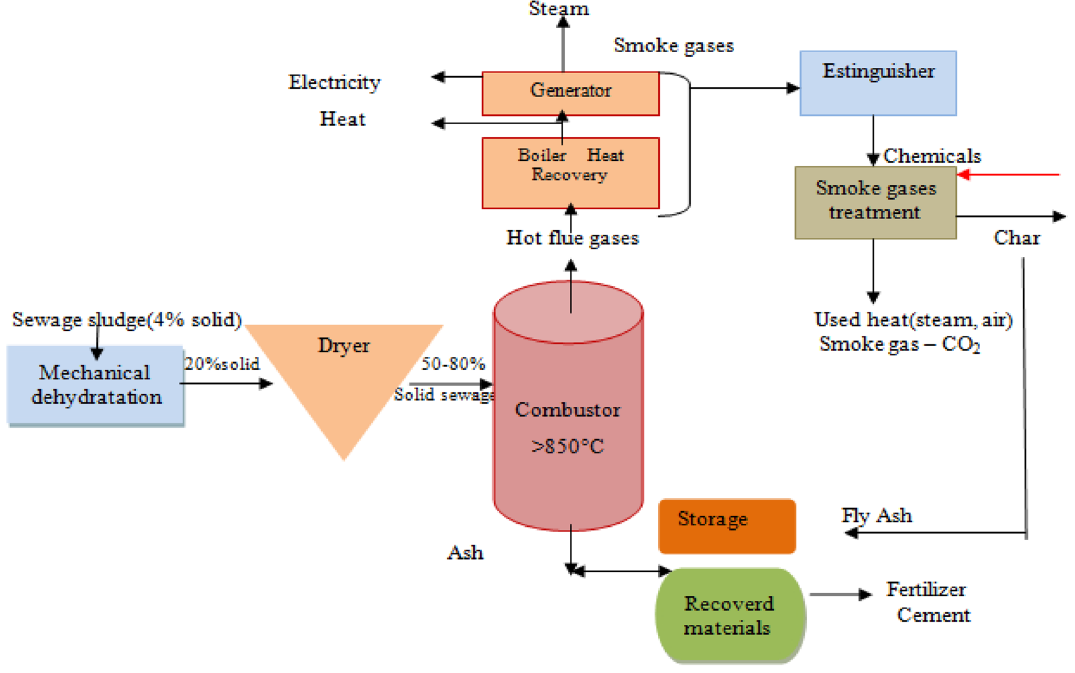
Fig. 4 Incineration of sewage sludge